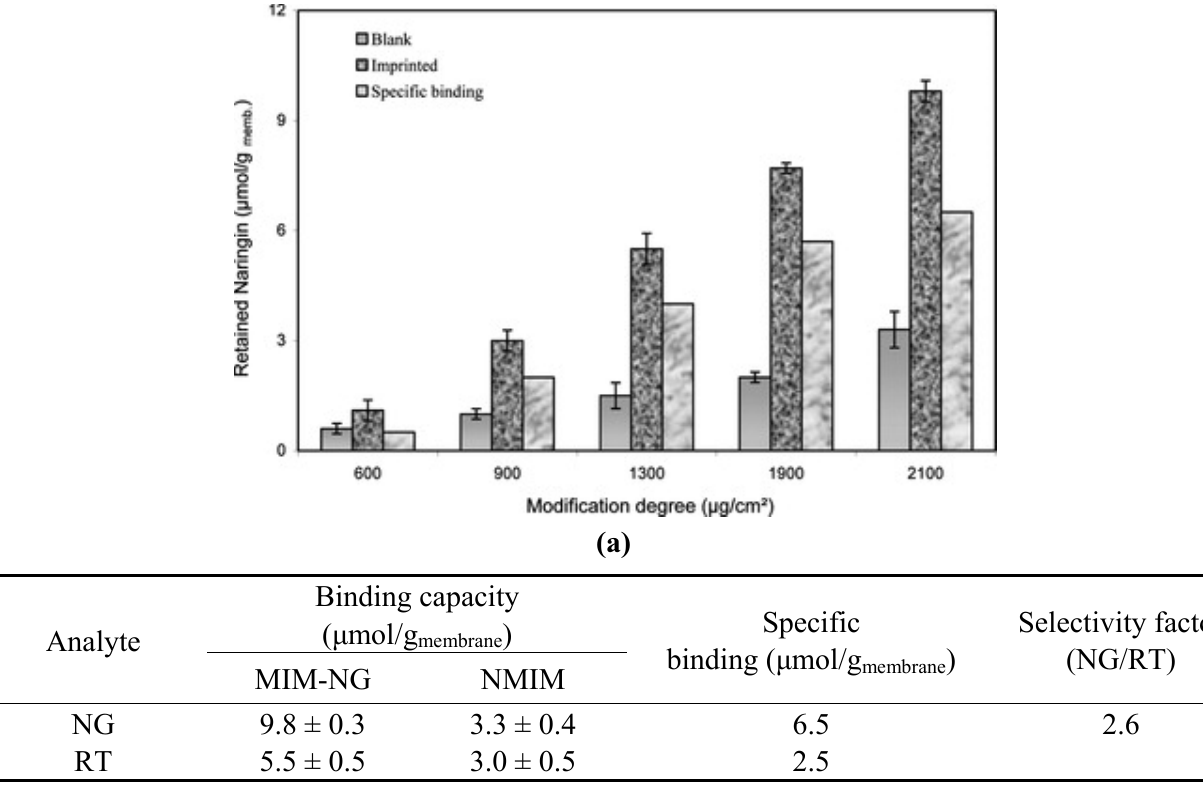
Figure 4. ( a ) NG retention on poly(4-VP/PVDF) NR-imprinted and its corresponding blank membrane at different modification degree; ( b ) Binding properties of NG-imprinted membrane and its corresponding